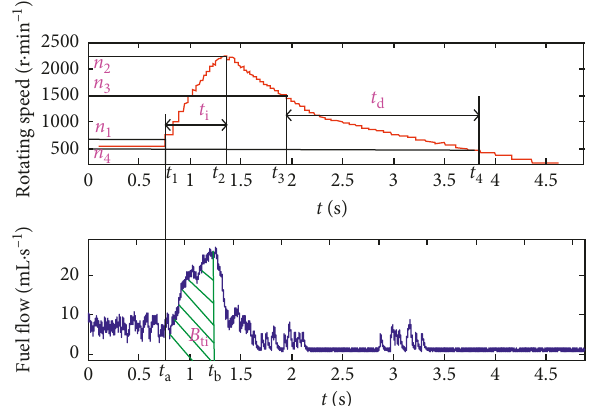
Figure 23: Characteristics of instantaneous and fuel